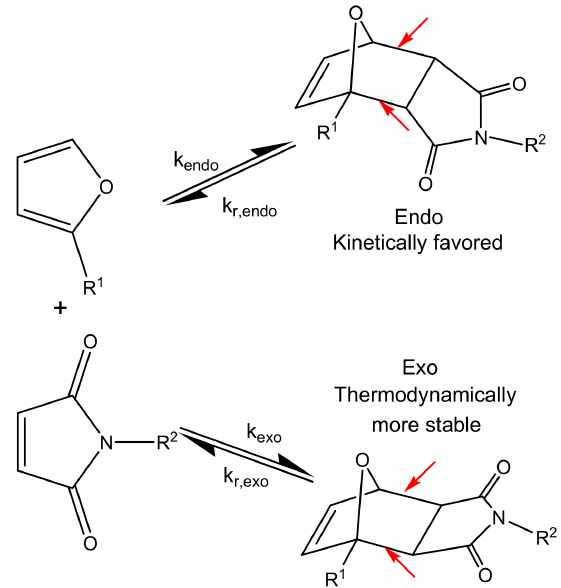
Figure 1. Furan-maleimide DA cycloadditions with formation of endo and exo stereoisomers. R 1 and R 2 represent flexible side groups with hydroxyl- and ether-functional groups. Reversible Diels–Alder bonds are indicated by red arrows. Adapted with permission from [9]. Copyright 2019 American Chemical